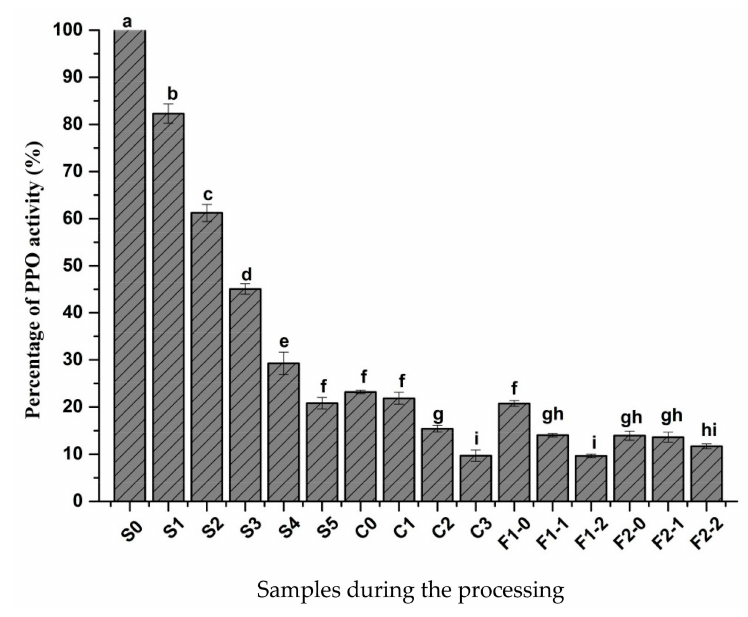
Figure 1. Changes in the relative polyphenol oxidase activity during the preparation of black pepper. Different letters (a, b, c, and so on) on the columns indicate significant differences between the samples ( p < 0.05). Data are presented as means ± standard error of mean. The meaning of S0, S1, and other samples is provided in Table 1.